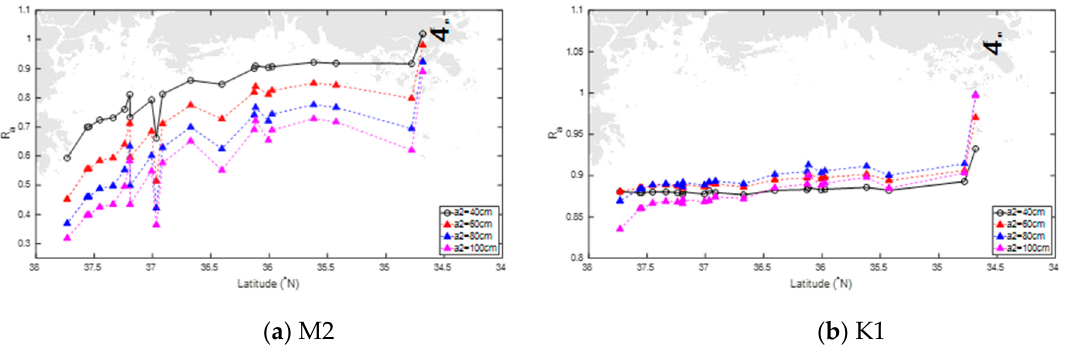
Figure 12. Value R a at tide station locations with respect to the increase of the amplitude of M2 ( a ) and K1 ( b ) at the open boundary B; ( a ): R a of M2’s amplitude; ( b ): R a of K1’s amplitude